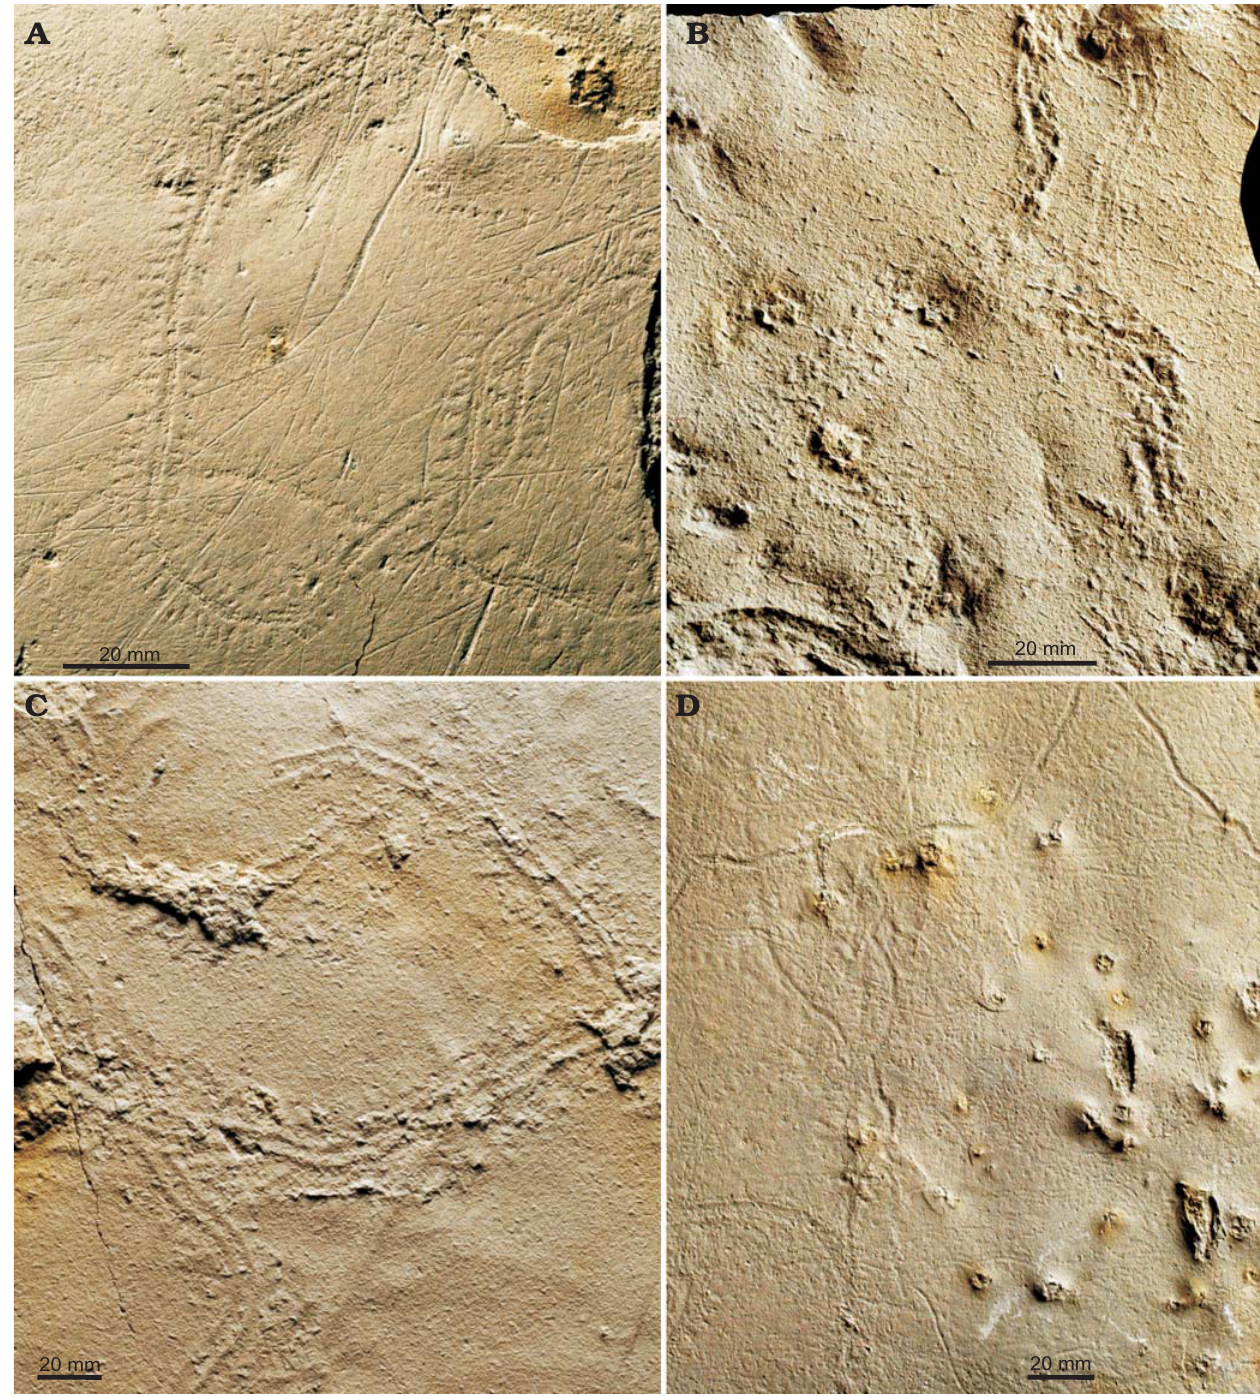
Fig. 6. Arthropod trace fossil Glaciichnium australis isp. nov., middle–late Eocene, Mount Wawel Formation, King George Island, Antarctica, slab ZPAL Tf.8/2007.1. A . The holotype (redrawn in Fig. 8A), epichnion. The narrow diagonal furrows are damage scratches. B . Very irregular form running between the lower plant stems. C . Hypichnial forms preserved mostly as the double central trail resembling the trace fossil Diplopodichnus . D . Epichnial, unilo- bated median trails resembling the trace fossil Helminthoidichnites . Also delicate median bilobated trails are present. Fig. 5. Arthropod trace fossil Glaciichnium australis isp. nov., resting trace, and lower plant stems on lower bedding surface, middle–late Eocene, Mount Wawel Formation, King George Island, Antarctica, slab ZPAL Tf.8/2007.8. A . General view, the long G. australis running from the base to the top shows different preservational variants. The knobs are plant stems. The resting trace (rt) in the lower part. B . Fragment of the long G. australis with thin blankets of underlying laminae covering the trace fossil. C . Fragment of the long G. australis crossed by another preserved mostly as the median trail, several cross sections of the lower plant stem. D . The resting trace (rt), several cross sections of the lower plant stem, and G. australis preserved mostly as the median trail. E . Resting trace, drawing (E 1 ) and photograph of close view (E 2 ).